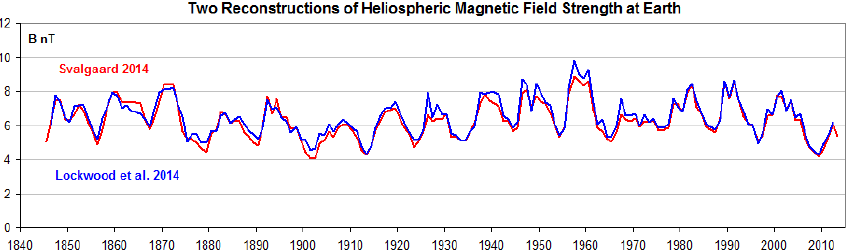
Figure 7. Comparison of the HMF strength deduced by Svalgaard and Cliver (2014) as shown in Fig. 6 (red curve) and inferred by Lockwood et al. (2014a) (blue curve). The coefficient of determination is R 2 = 0 .